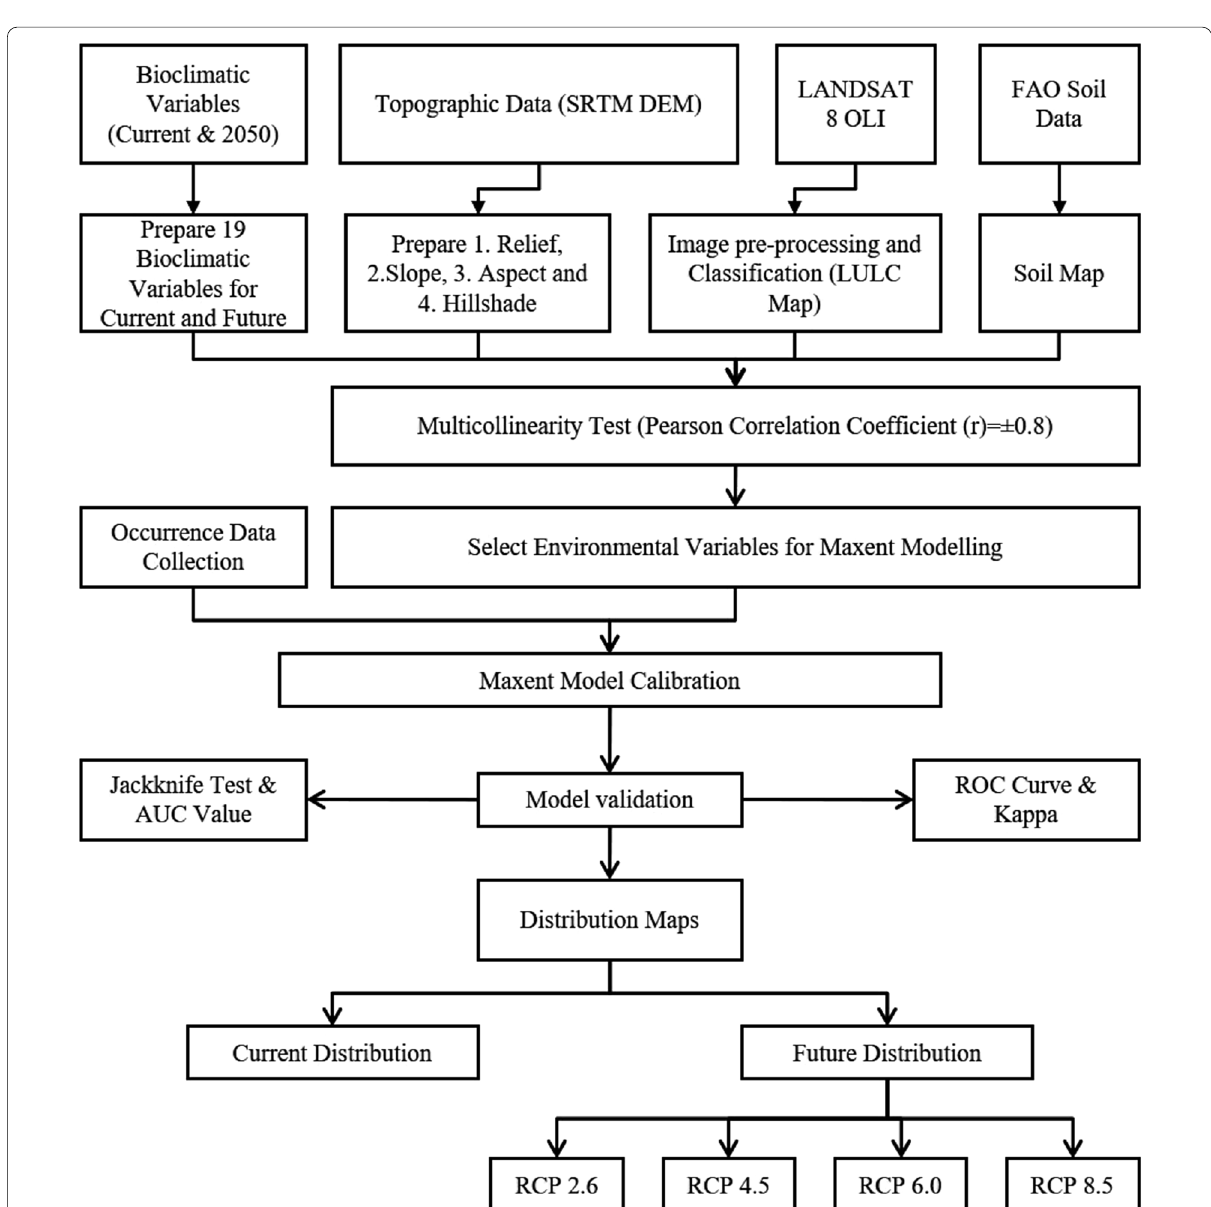
Fig. 2 Flow diagram of the methodology adopted